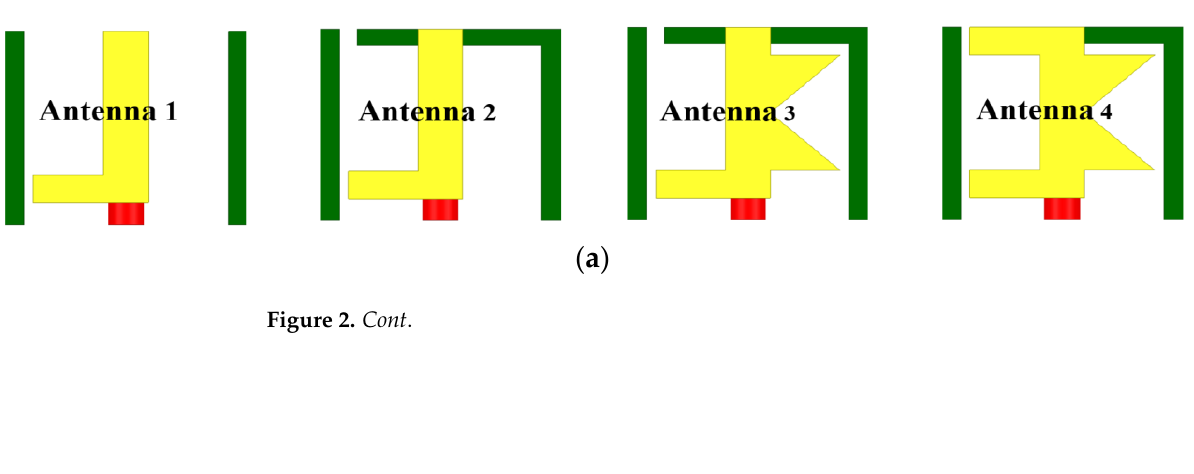
( b ) Figure 2. Design development and S-parameters of antenna unit: ( a ) the design evolution; ( b ) sim- ulated S 11 . Figure 3 shows the simulation result of the surface current distribution of the pre- sented antenna. The surface current distribution is concentrated on the rectangular strip of the top of the rectangular groove and two triangle-shaped strips at 3.4 GHz. When the frequency is 4.9 GHz, the surface current is mostly focused on the C-shaped strip. ( a ) ( b ) Figure 3. Simulated surface current distribution at ( a ) 3.4 GHz; ( b ) 4.9 GHz. In Figure 4, the S 11 simulation results of the designed antenna with dissimilar values of W and H are presented. When W is 3.85 mm, Figure 4a demonstrated that S 11 of − 10 dB bandwidth satisfies the frequency band at 3.22–5.6 GHz, which contains 3.3–5 GHz. As shown in Figure 4b, the − 10 dB S 11 can meet the requirement of the entire band range when the value of H is 0.8 mm. 3.0